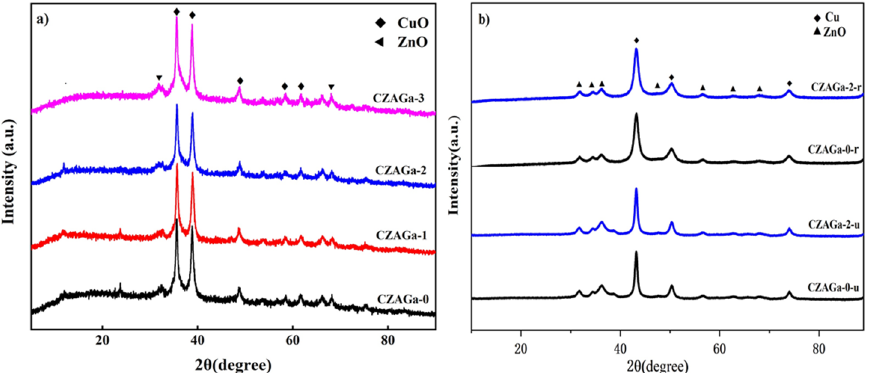
Figure 3. XRD patterns of the samples: ( a ) calcined catalysts, ( b ) reduced (r) and used (u) catalysts. The XRD patterns of the functioning catalysts CZAGa-0 and CZAGa-2 after